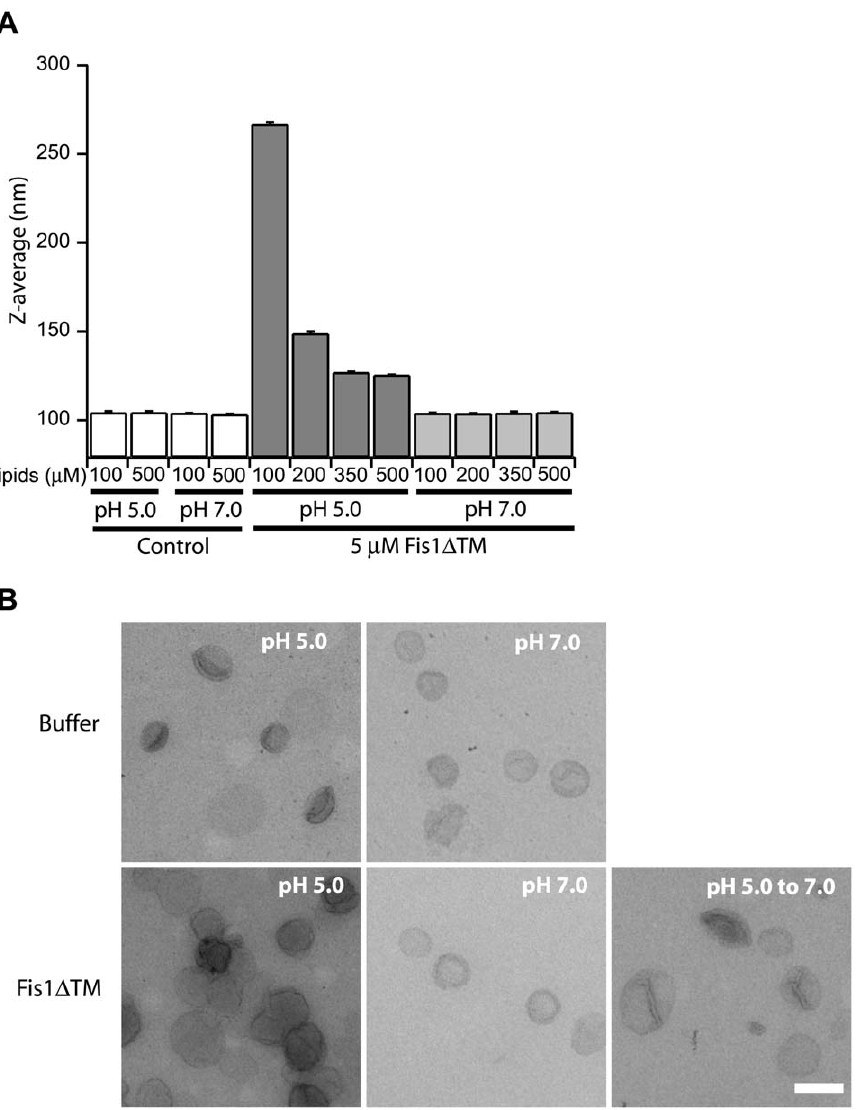
Figure 7. Fis1 D TM affects vesicle size and shape at pH 5.0, but not pH 7.0. Lipid vesicle size was determined in the presence and absence of Fis1 D TM at pH 5.0 or pH 7.0 by dynamic light scattering(A) and negative stain electron microscopy(B). Vesicle size is reported by Z-average values for dynamic light scattering in (A) and the scale bar is 200 nm in (B). For these experiments, 100 nm lipid vesicles were incubated for 2 hours at 25 u C with buffer at pH 7.0, pH 5.0 or with 5 m M Fis1 D TM at pH 7.0, or pH 5.0 (1:20 protein:lipid). To assess vesicle size upon returning to pH 7.0, vesicles were incubated in the presence of 5 m M Fis1 D TM at pH 5.0 for 1 hour, then a 50 6 pH 7.0 buffer was added to adjust the pH to 7.0, (15% change in volume). Samples were incubated for 1 additional hour at pH 7.0 and then put on grids and